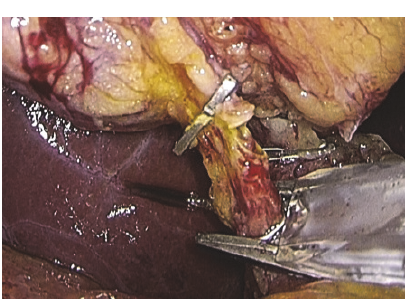
Figure 2: Partial cysticotomy.